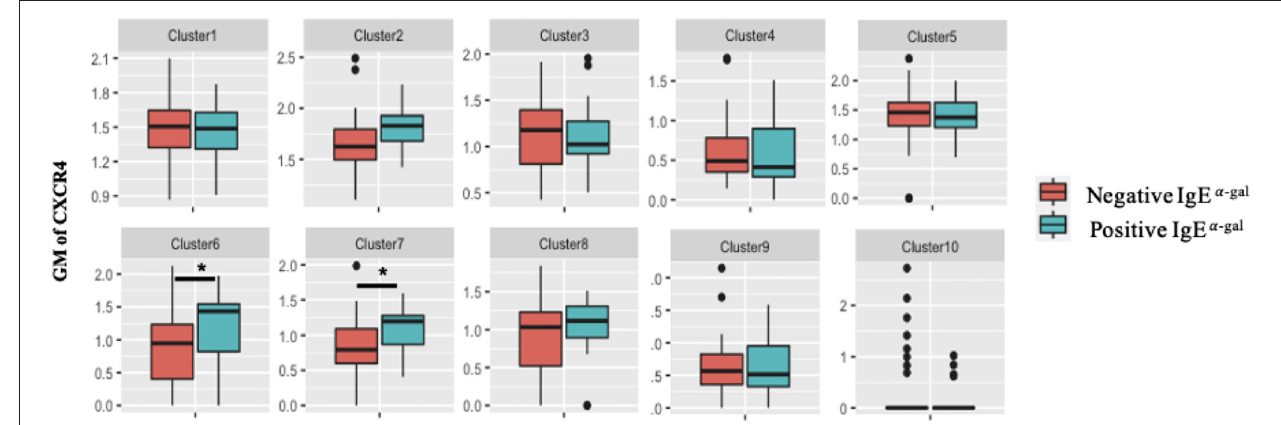
FIGURE 4 | CCR6 and CXCR4 are important for immunoglobulin isotype switching. (A) Percentage of SWM of total B cells at day 0 before stimulation and at day 10 post with 20ng/mL IL-4 and ± 10 ug/mL anti-CD40 stimulation. (B–D) Percentage of IgG + , IgE + , and CD138 + of CCR6- SWM or CCR6 + SWM at day 0 (B) , day 3 (C) , and day 10 (D) after culturing with 20ng/mL IL-4 and 10 ug/mL anti-CD40. (E–G) Percentage of IgG + , IgE + , and CD138 + of CXCR4- SWM or CXCR4 + SWM at day 0 (E) , day 3 (F) , and day 10 (G) after with 20ng/mL IL-4 and 10 ug/mL anti-CD40. * p < 0.05 by Mann-Whitney test.